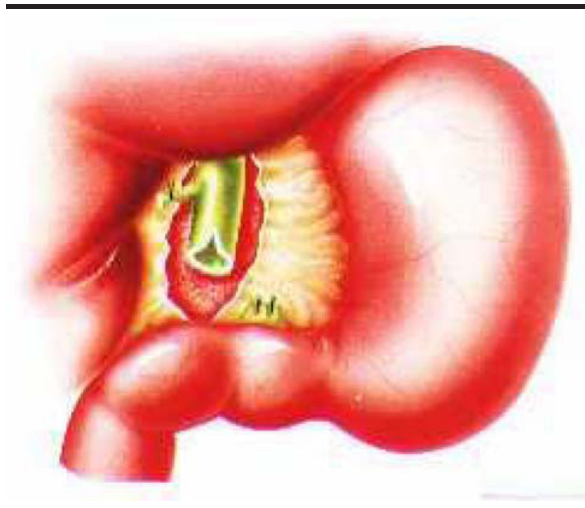
FIGURA 7 - Desenho mostra a incisão longitudinal de 3 mm na parede anterior do colédoco.